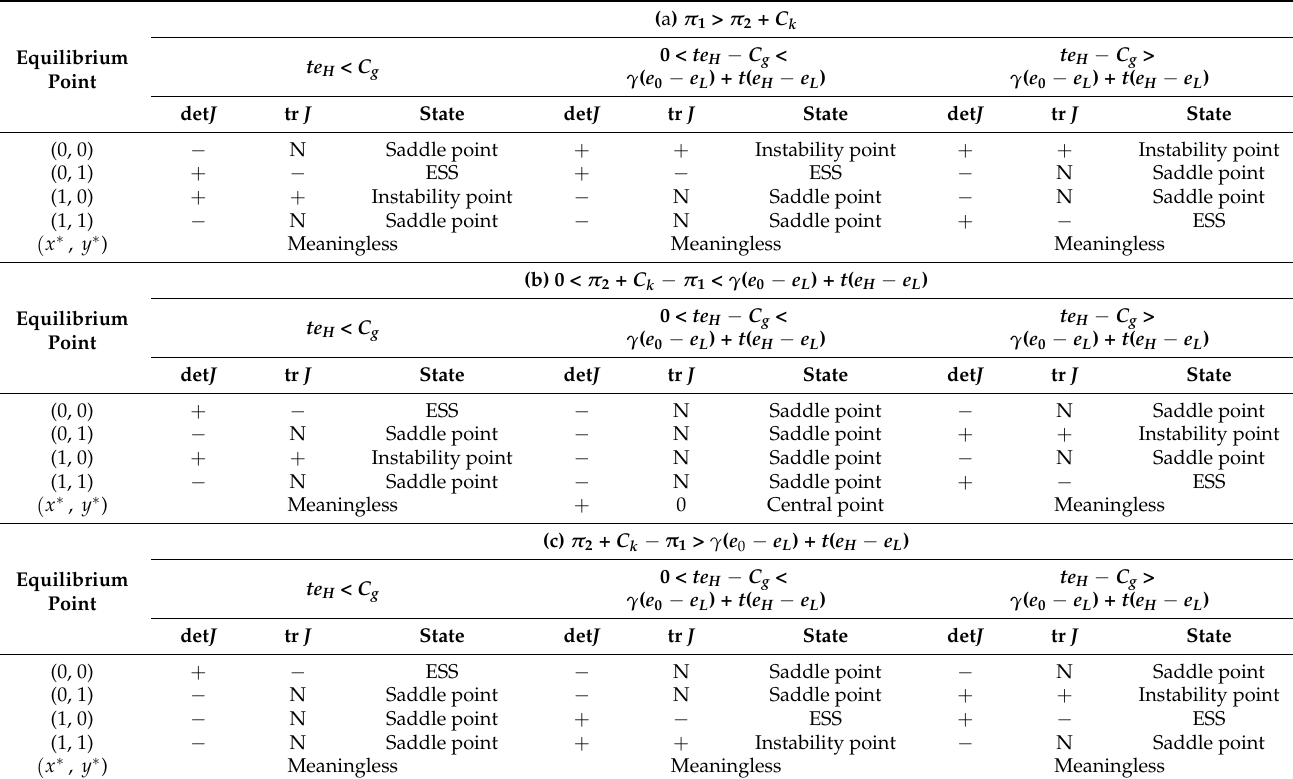
Table 3. Stability analysis of nine